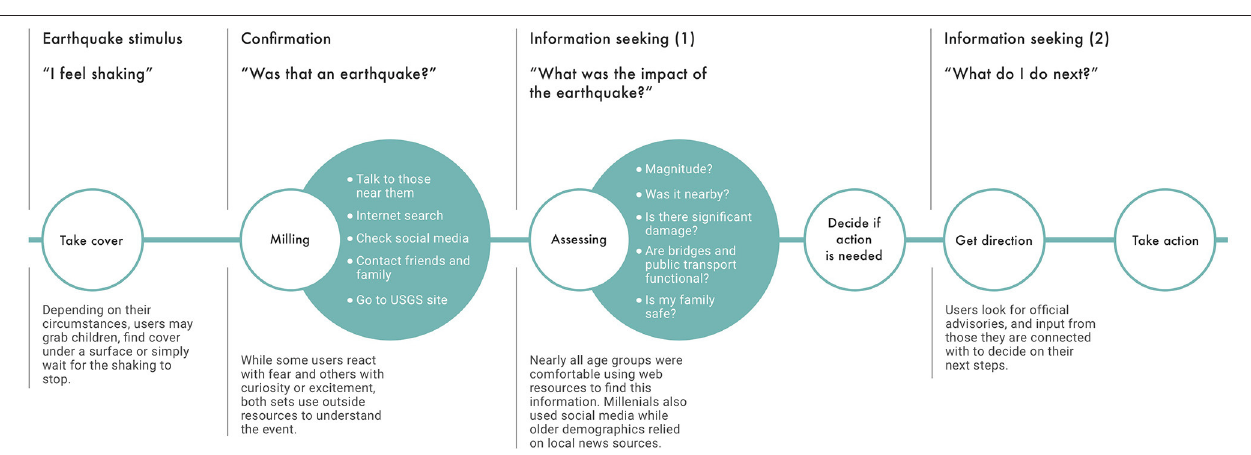
when an expert had some insight and a user expanded on the same